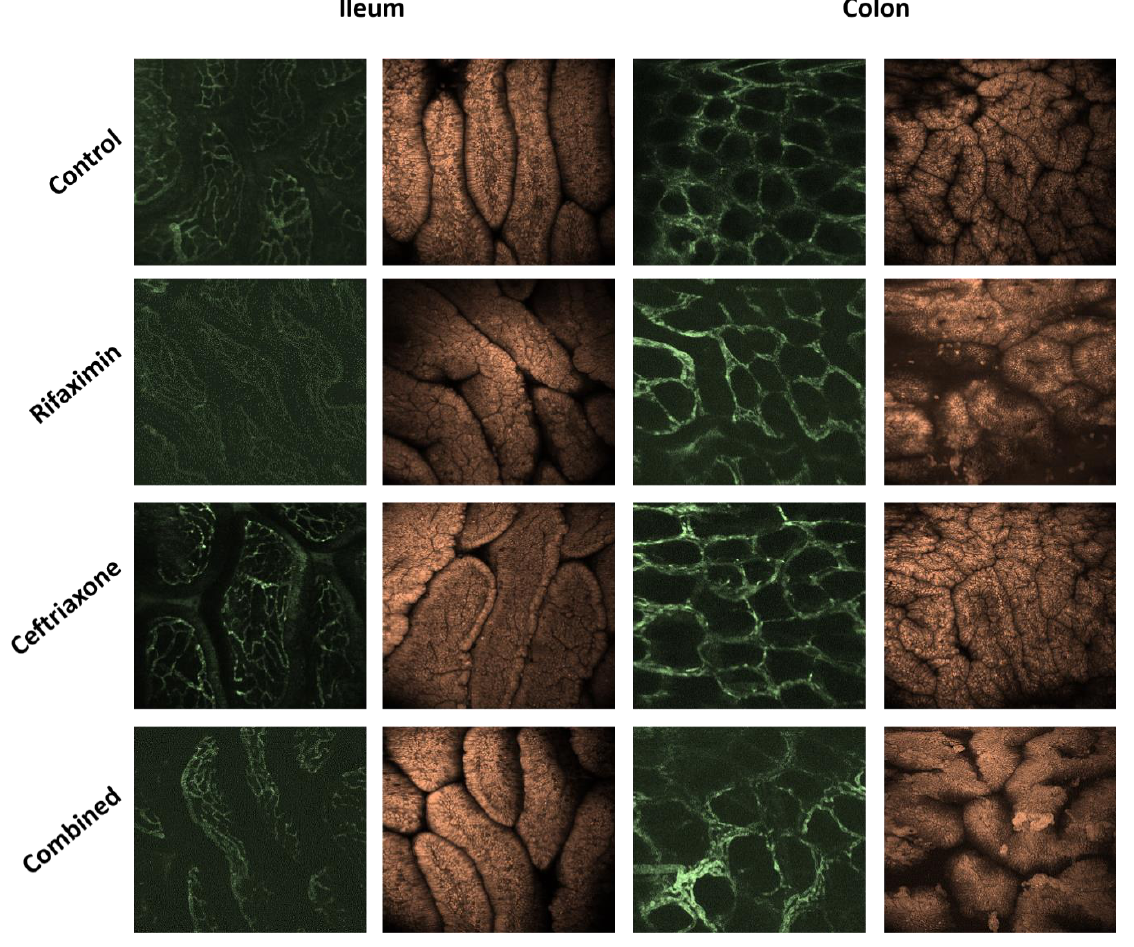
Figure 4. In vivo histology of the luminal surface of the small intestine and colon using CLSM. Mi- crovascular structures were visualized with i.v. FITC-dextran and the mucosal surface with topical i.v. FITC-dextran and the mucosal surface with topical acriflavine dye. Microvascular structures were visualized with acriflavine